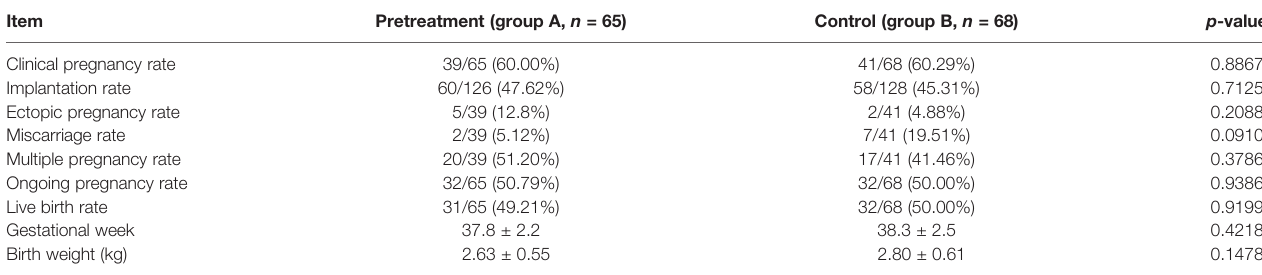
TABLE 2 | Comparison of the pregnancy outcomes between groups (intention-to-treat analysis). Item Clinical pregnancy rate